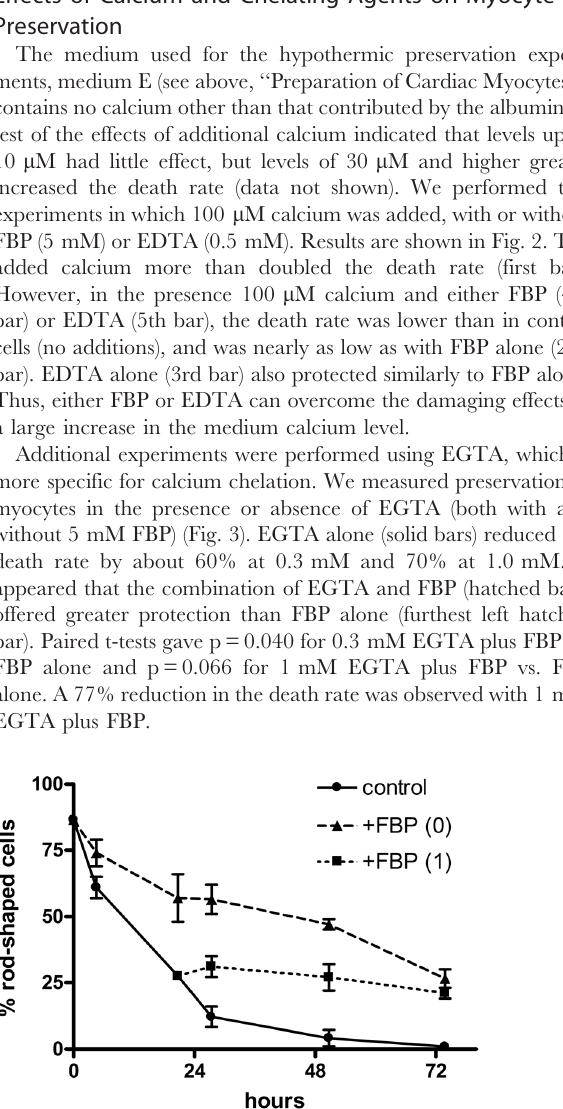
Figure 3. Effects of EGTA on hypothermic preservation. In this figure and in Figure 5, death rates for treated cells were normalized to those of control cells in the same experiment, and the relative death rates averaged over all experiments. Filled bars in these figures are for treatments without FBP, while hatched bars are for treatments including 5 mM FBP. Results are means of 4 determinations; error bars indicate S.E.M. In this figure, myocytes were incubated with the indicated concentrations of EGTA. Statistically significant by paired t- tests: **, p , 0.01 vs. control; ***, p , 0.005 vs. control; + , p , 0.05 vs. FBP alone.